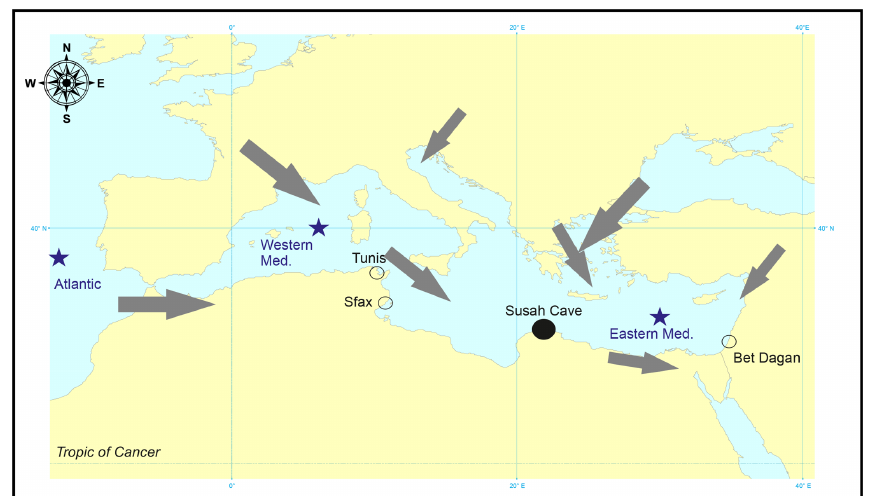
Figure 1. Map showing the location of Susah Cave (filled circle) and GNIP sites (open circles) used in Sect. 4.1. Blue stars indicate sources of marine water evaporation discussed in the text. Grey arrows indicate recent average winter wind